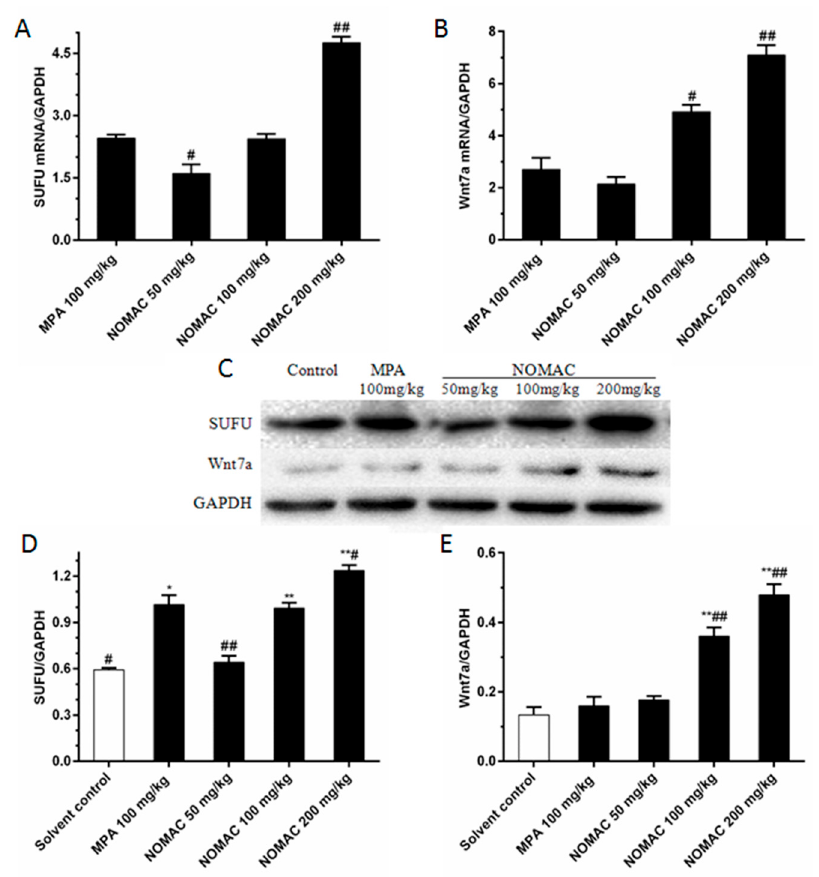
Figure 7. Effects of NOMAC and MPA on the levels of SUFU and Wnt7a in xenograft mouse tumor tissues, as assessed by RT-qPCR and Western blotting. Mice were treated with 50, 100, or 200 mg/kg NOMAC or 100 mg/kg MPA. ( A , B ) The change in mRNA expression levels of SUFU and Wnt7a in RL95-2 xenograft mice tumor tissues. Data are presented as fold changes relative to the expression of GAPDH. * p < 0.05, ** p < 0.01 vs. control; # p < 0.05, ## p < 0.01 vs. MPA; ( C ) The protein expression of SUFU and Wnt7a in response to NOMAC and MPA treatment in xenograft mouse tumor tissues; ( D , E ) SUFU and Wnt7a protein production is determined using Western blot. GAPDH is used as a loading control. * p < 0.05, ** p < 0.01 vs. relative to the control group; # p < 0.05, ## p < 0.01 vs. relative to the MPA group.